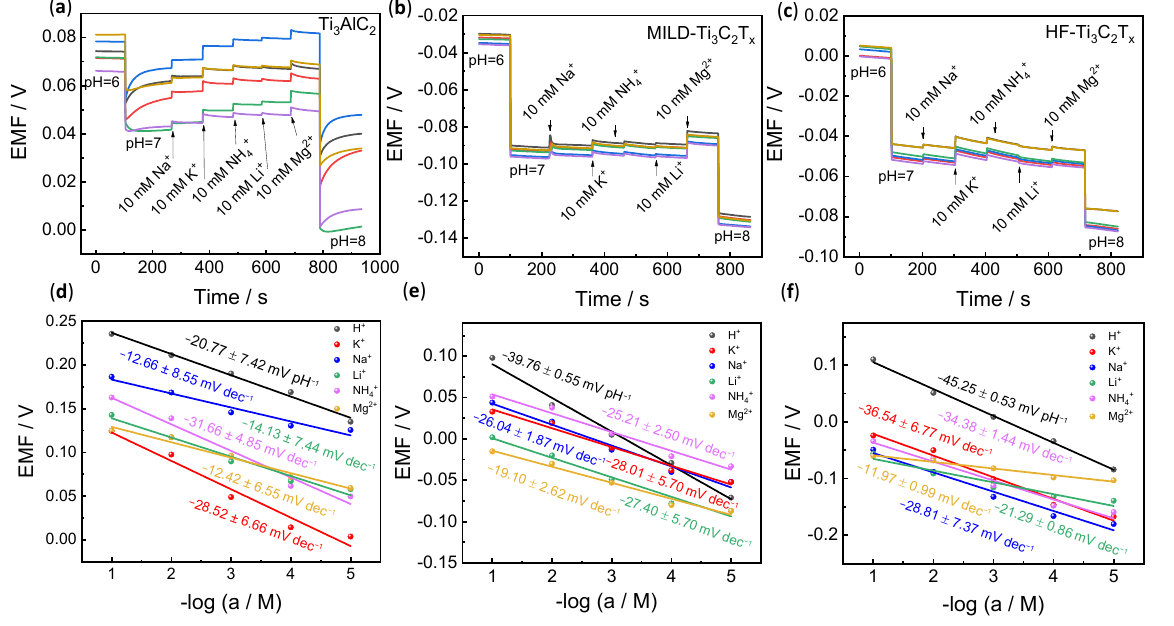
Figure 4. Selectivity evaluation. ( a – c ) The selectivity examination of Ti 3 AlC 2 , MILD-Ti 3 C 2 T x , and HF-Ti 3 C 2 T x by continually adding interfering ions. ( d – f ) The selectivity examination of Ti 3 AlC 2 , MILD-Ti 3 C 2 T x , and HF-Ti 3 C 2 T x by separation solution method. All potentiometric tests were performed on six individual electrodes ( n = 6). The data represent the average values. Corresponding potentiometric response curves are shown in Figures